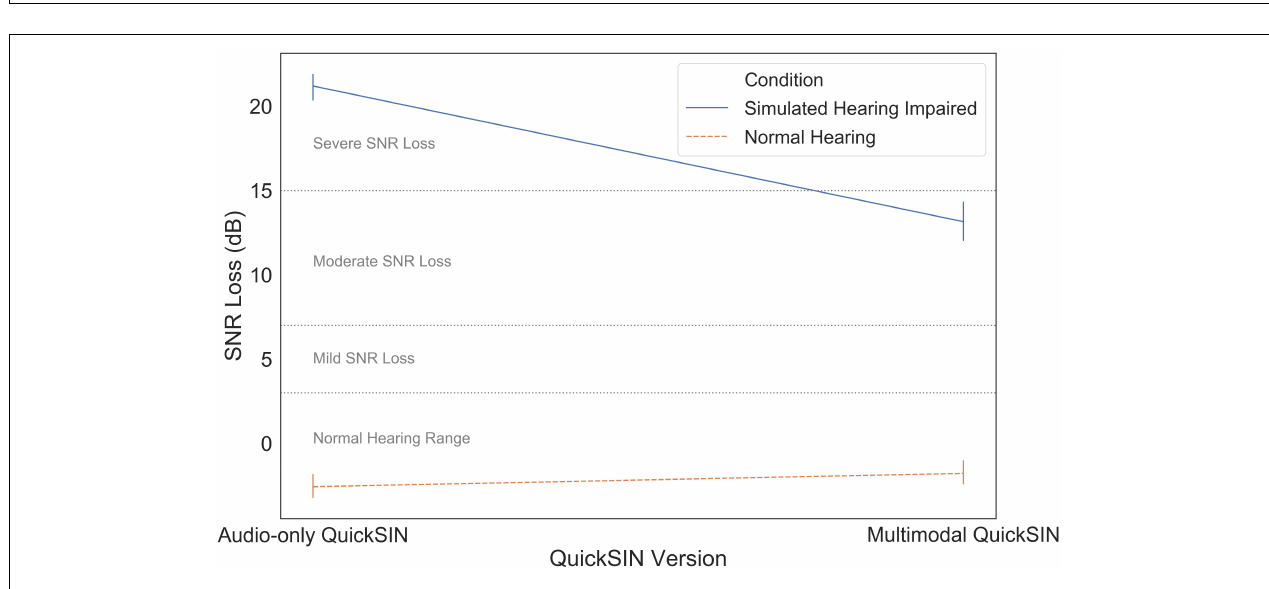
FIGURE 5 | Heatmaps across SNR and hearing impairment for the multimodal QuickSIN. Regions that are red or yellow indicate greater visual attention, while green regions indicated lesser visual attention.